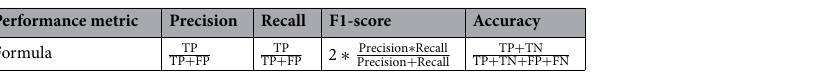
Table 3. Performance metric calculation